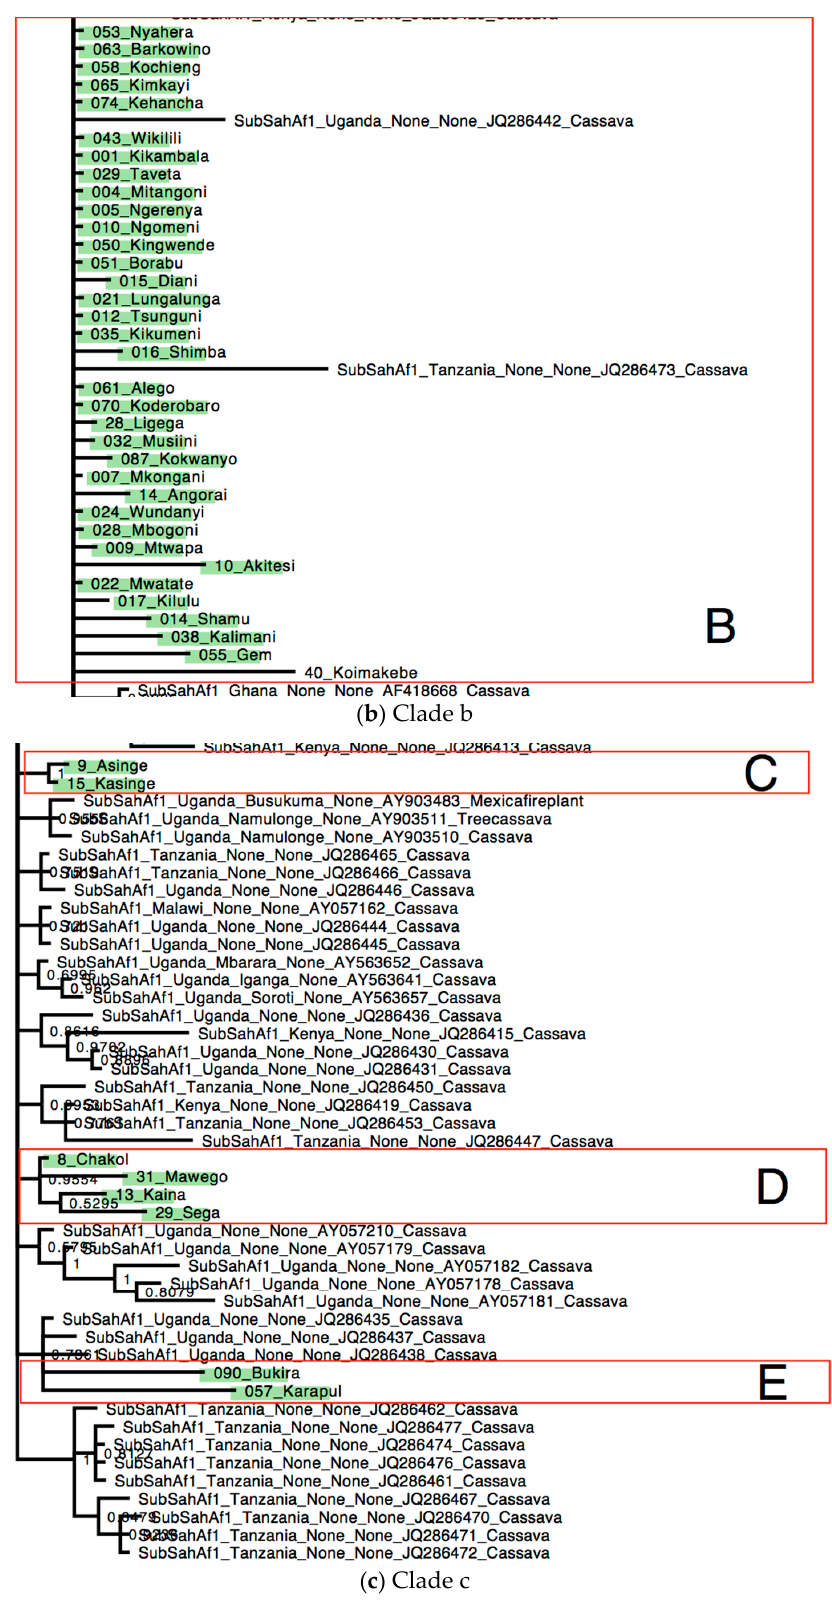
Figure A1. ( a–c ): Distinct clades A–E blown up below with new sequences generated in this study highlighted in green.